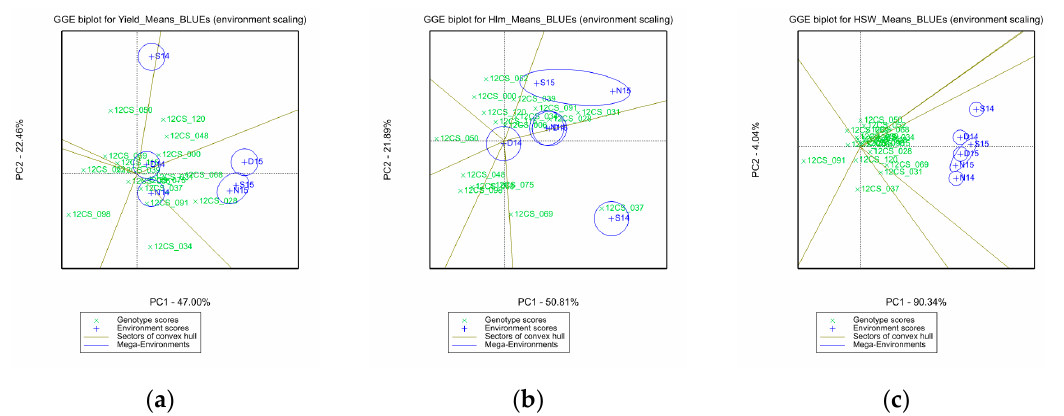
Figure 4. Genotype × environment interaction effects (GGE) biplot based on mega-environments. Mega-environments identified in the AMMI analysis are represented in blue, genotypes are in green, and the polygon view is in brown. ( a ) GGE biplot for pod yield (Yield), ( b ) GGE biplot for haulm yield (Hlm), and ( c ) GGE biplot for 100 seed weight (HSW).